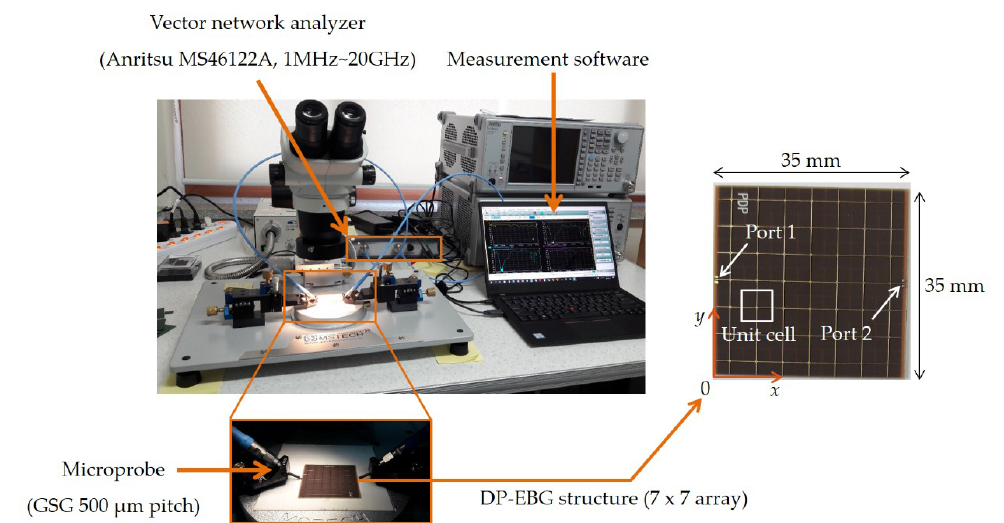
Figure 11. Measurement setup for DP–EBG structure with a 7×7 array.